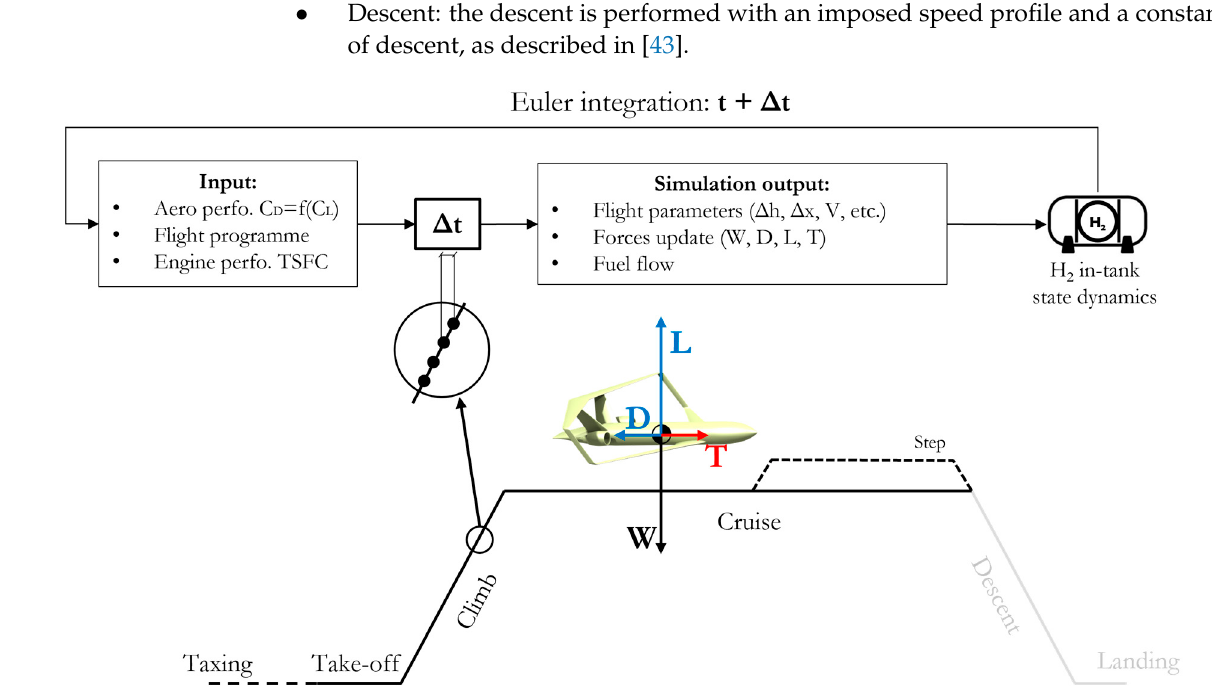
Figure 15. Standard mission simulation scheme.